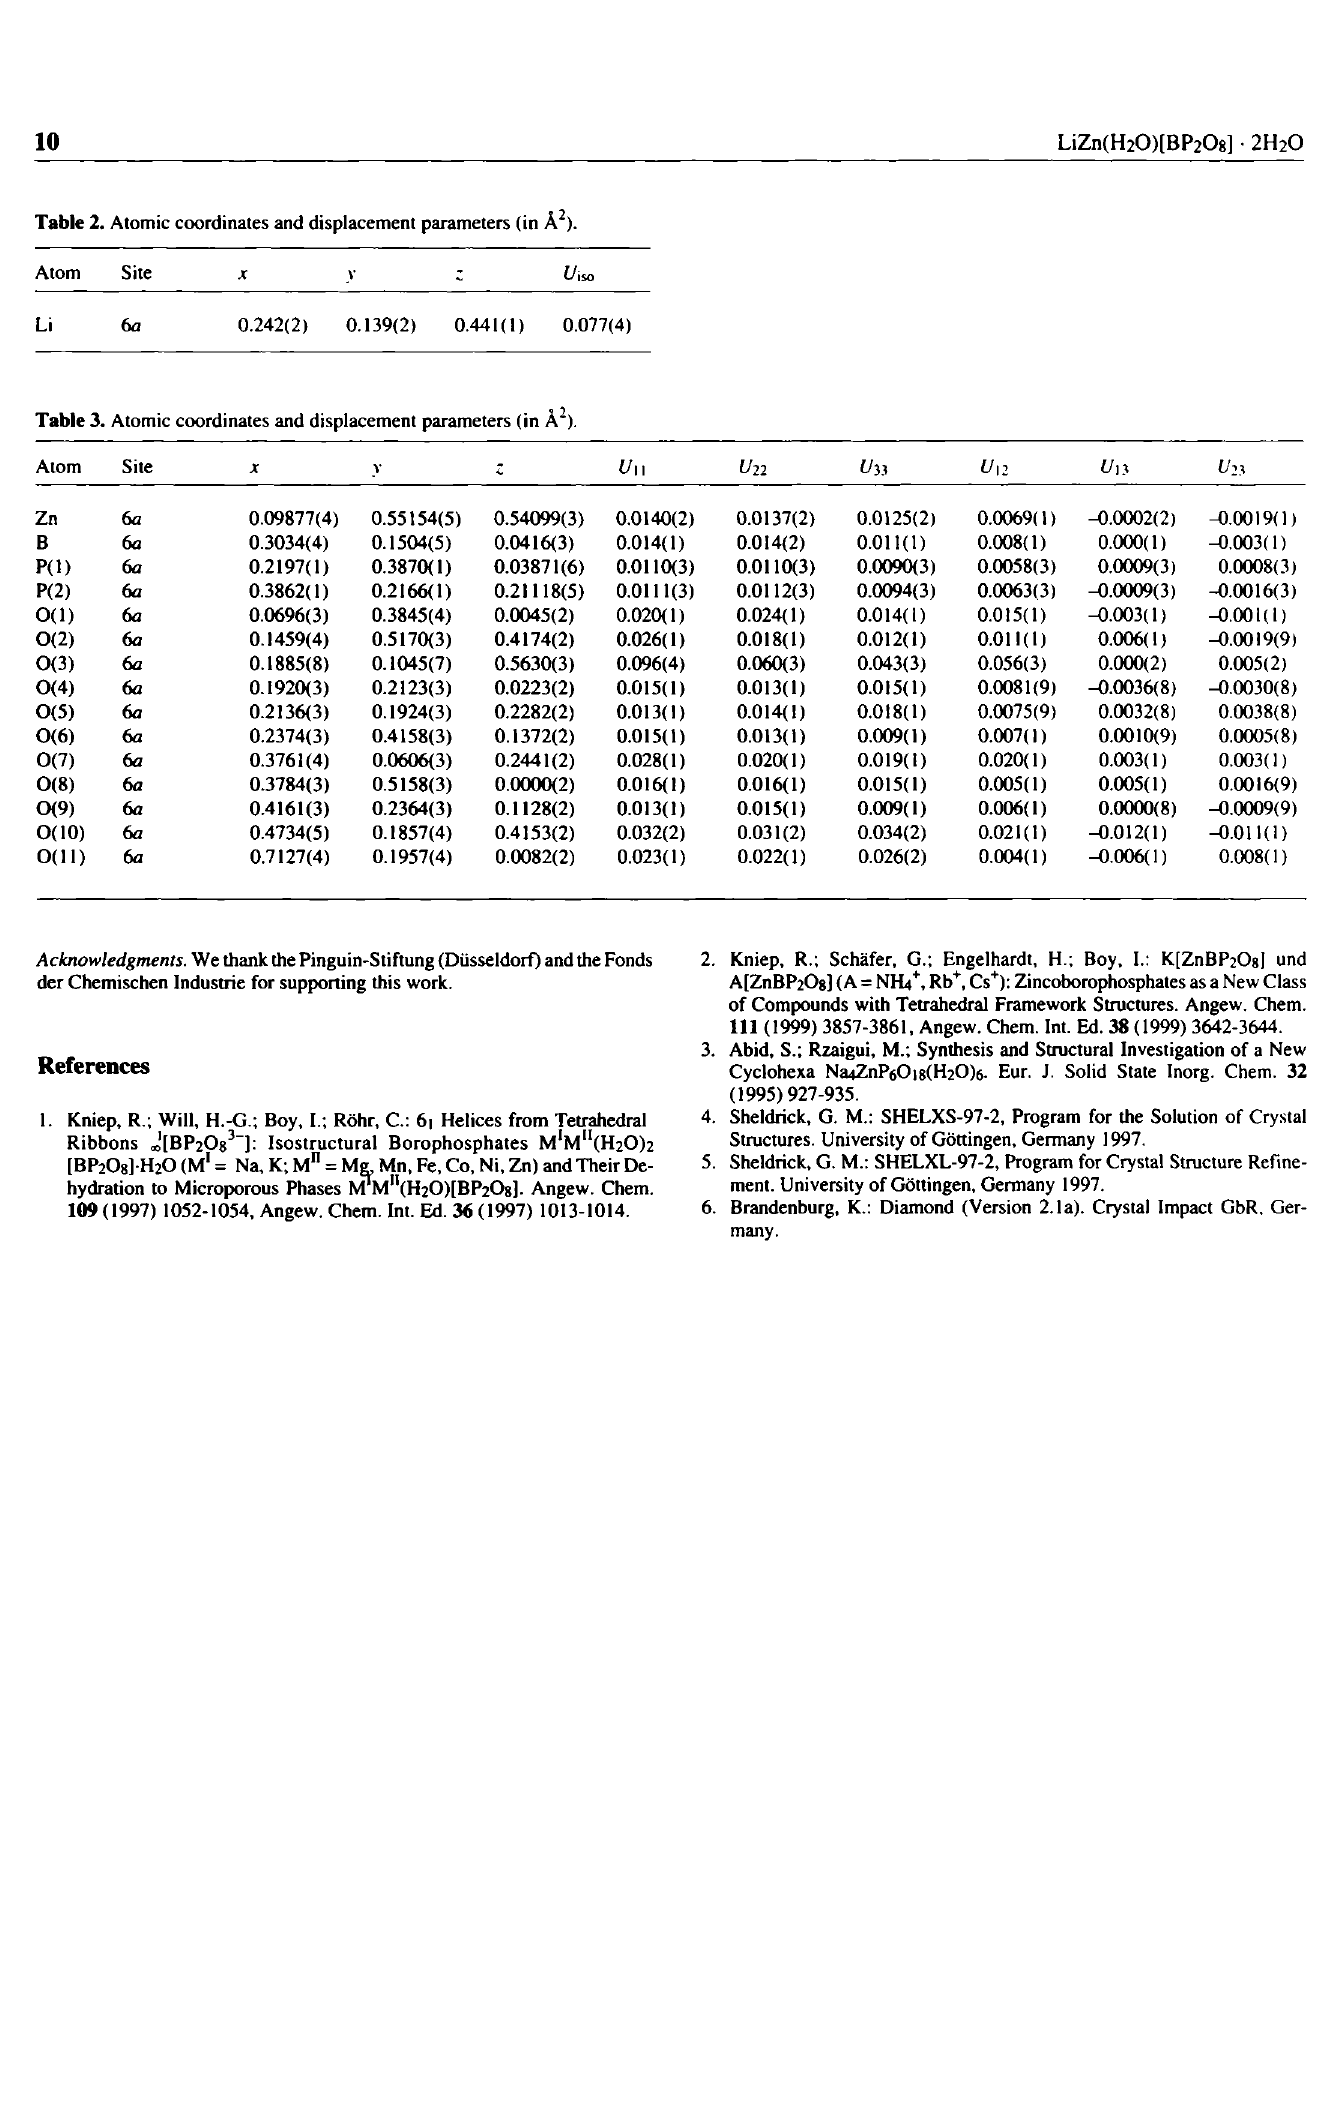
Table 3. Atomic coordinates and displacement parameters (in